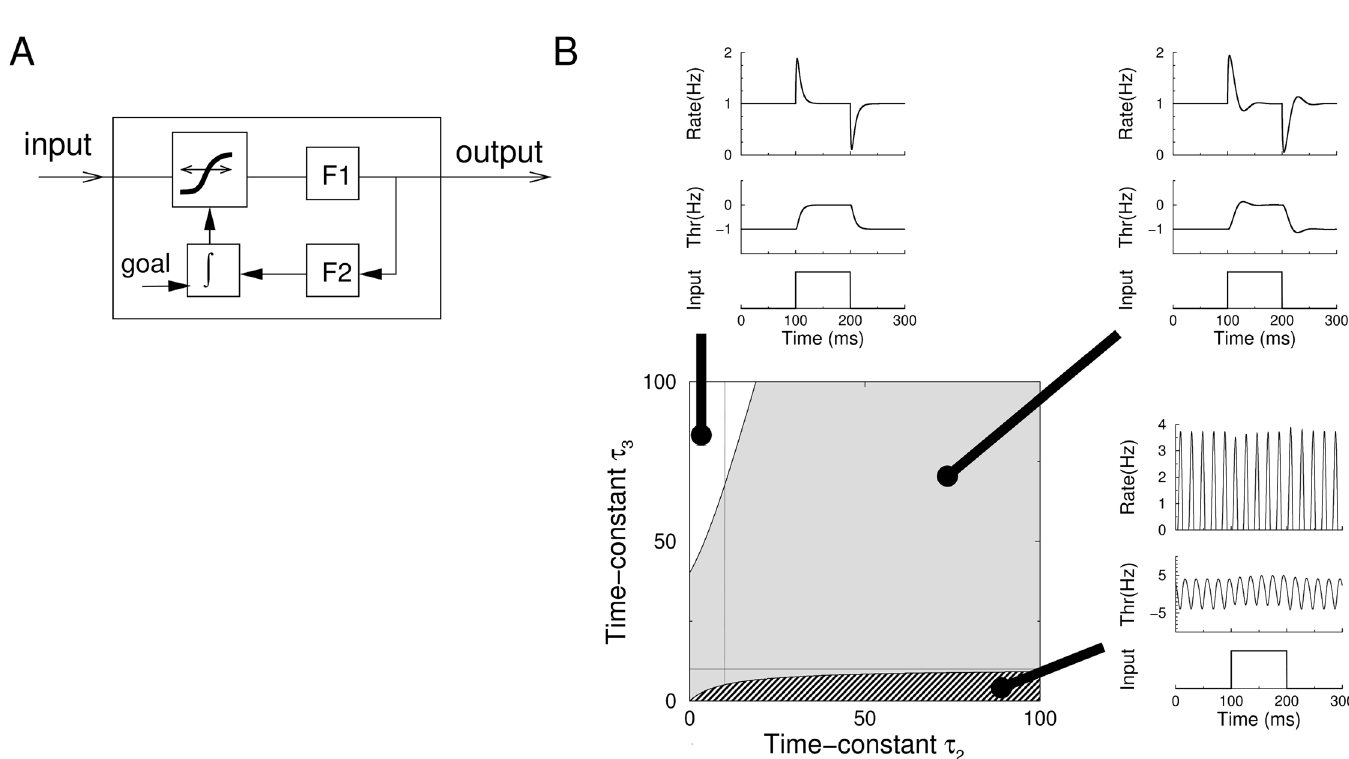
Fig 1. Single neuron homeostasis. A) Schematic illustration of the homeostatic model. The input current is transformed through an input-output relation and a filter. The input-output curve is shifted by a filtered and integrated copy of the output firing rate, so that the average activity matches a preset goal value. F2 (time-constant τ F1 (time-constant τ 1 ) denotes a filter describing the filtering between input and output of the neuron; 2 ) is a filter between the output and the homeostatic controller. B) The response of the model for various settings of the homeostatic time-constants. The value of τ 1 was fixed to 10ms (thin lines), while τ 2 and τ 3 were varied. Center plot: the response of the neuron can either be stable (top left plot; white region), a damped oscillation (top right plot, gray region), or unstable (bottom right plot, striped region). The surrounding plots show the firing rate of the neuron and the threshold setting in response to a step